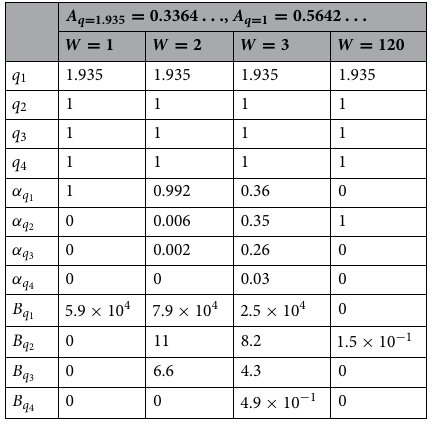
Table 1. The obtained parameter values of the probability distributions for K = 0.1 systems given in Fig.